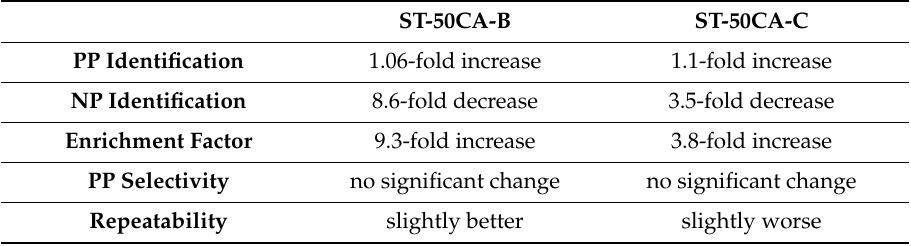
Table 4. The change in method performance parameters as compared to the ST-50CA method when using ST-50CA-B and ST-50CA-C